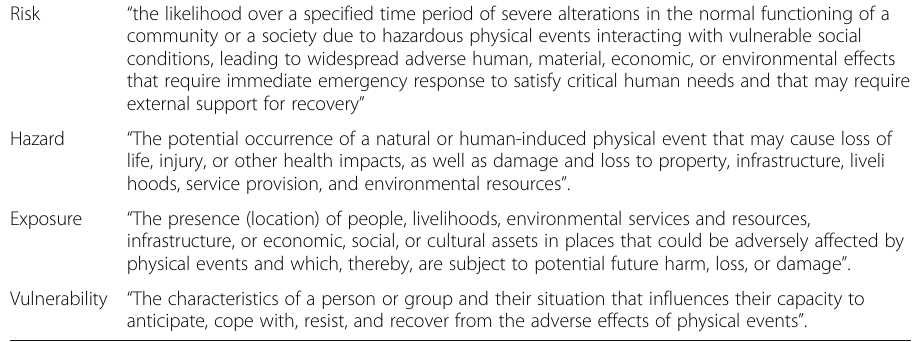
Table 1 Definitions of risk, hazard, exposure and vulnerability according to the IPCC (2012,